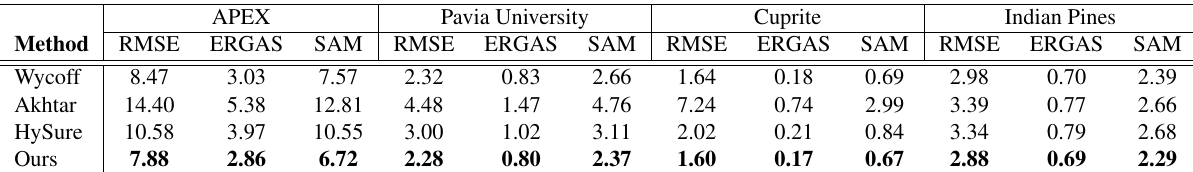
Table 1. Quantitative results for all tested